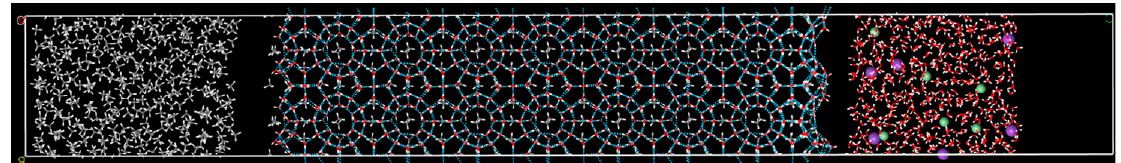
Figure 1. Snapshot of the initial configuration of the three-phase system. H 2 O molecules in red and white and CH 4 molecules in white and gray colors. The green and purple dots in the H 2 O slab represent Na and Cl ions, respectively. The blue dotted lines in hydrate slab are the hydrogen bond network.